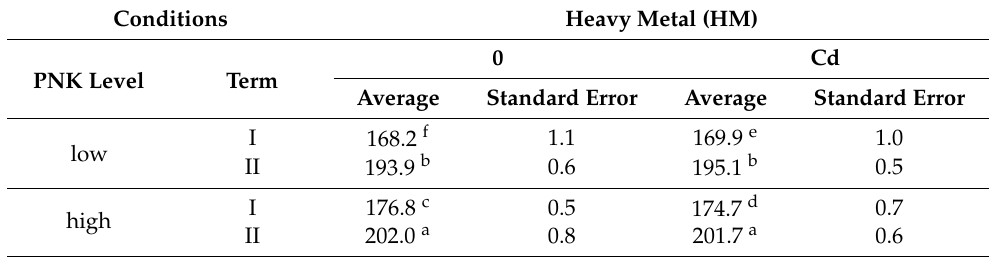
Table 9. The electrolytic conductivity in water ( µ g · cm − 1 ) in the three tested growing seasons.